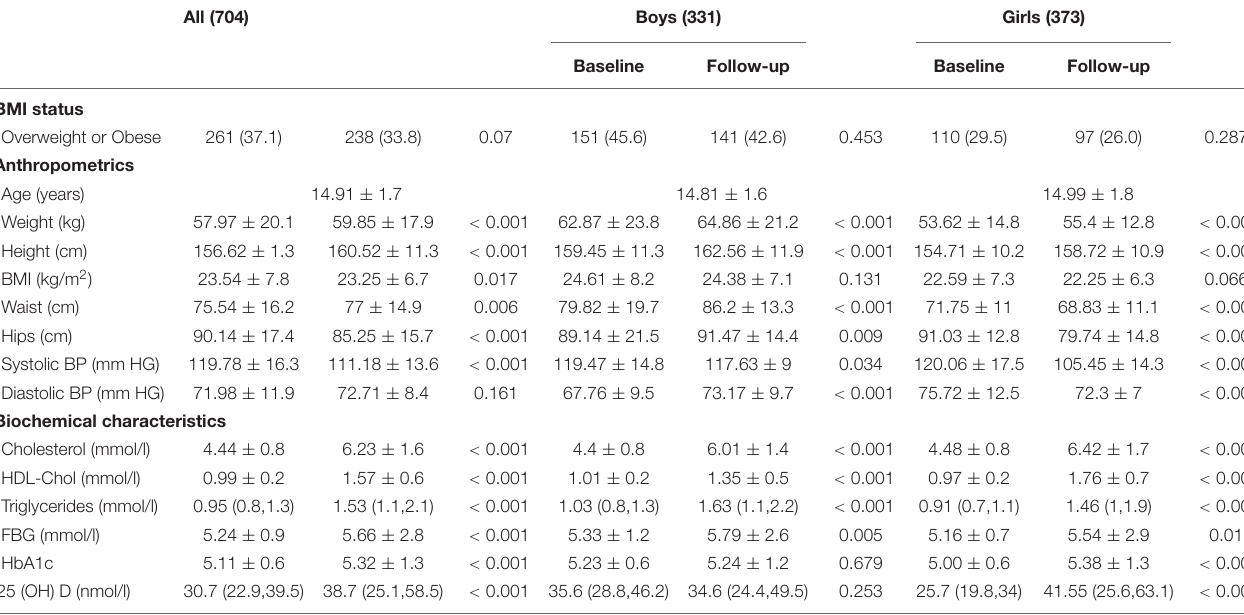
TABLE 3 | Change in anthropometry and biochemical characteristics for those who completed the lifestyle change educational program. All (704)